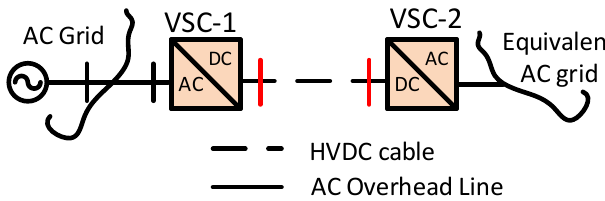
Figure 1. HVDC (High voltage direct current) point-to-point link.